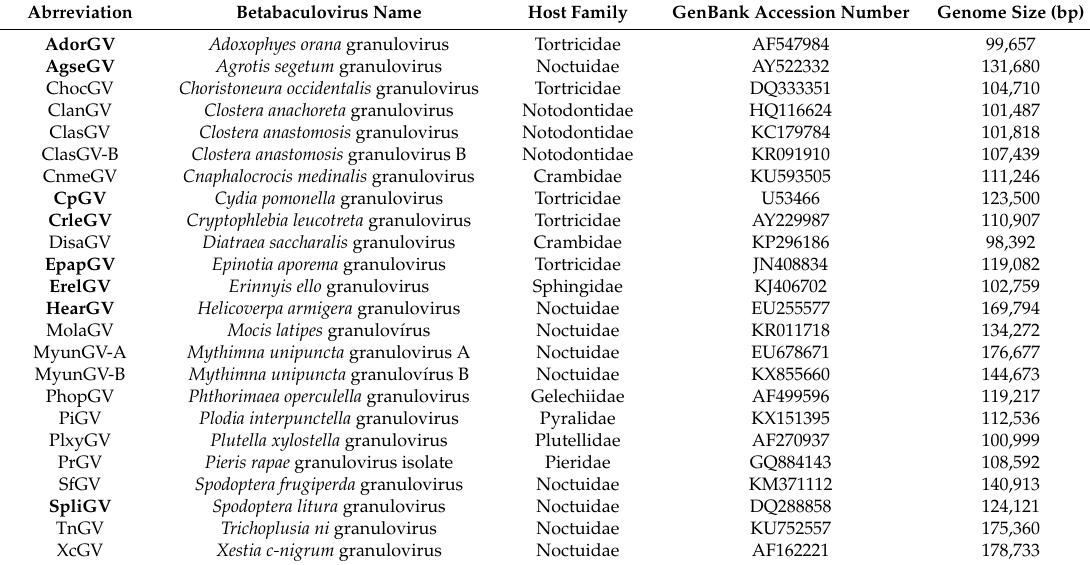
Table 1. List of betabaculoviruses (24 species) which have complete genomic sequences available in GenBank (August 2018). Granuloviruses (GVs) chosen as the representative group in this study are shown in